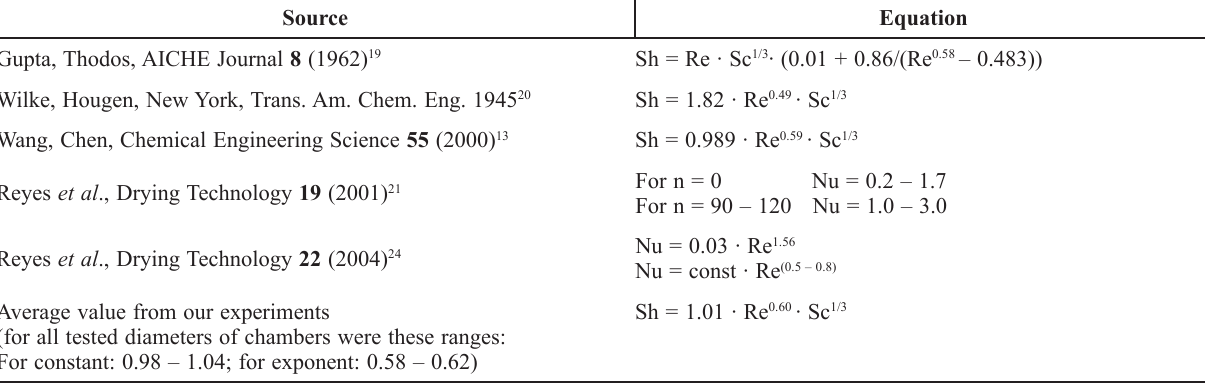
Table 2 – Equations describing heat and mass transfer in mixed fluidized bed dryer